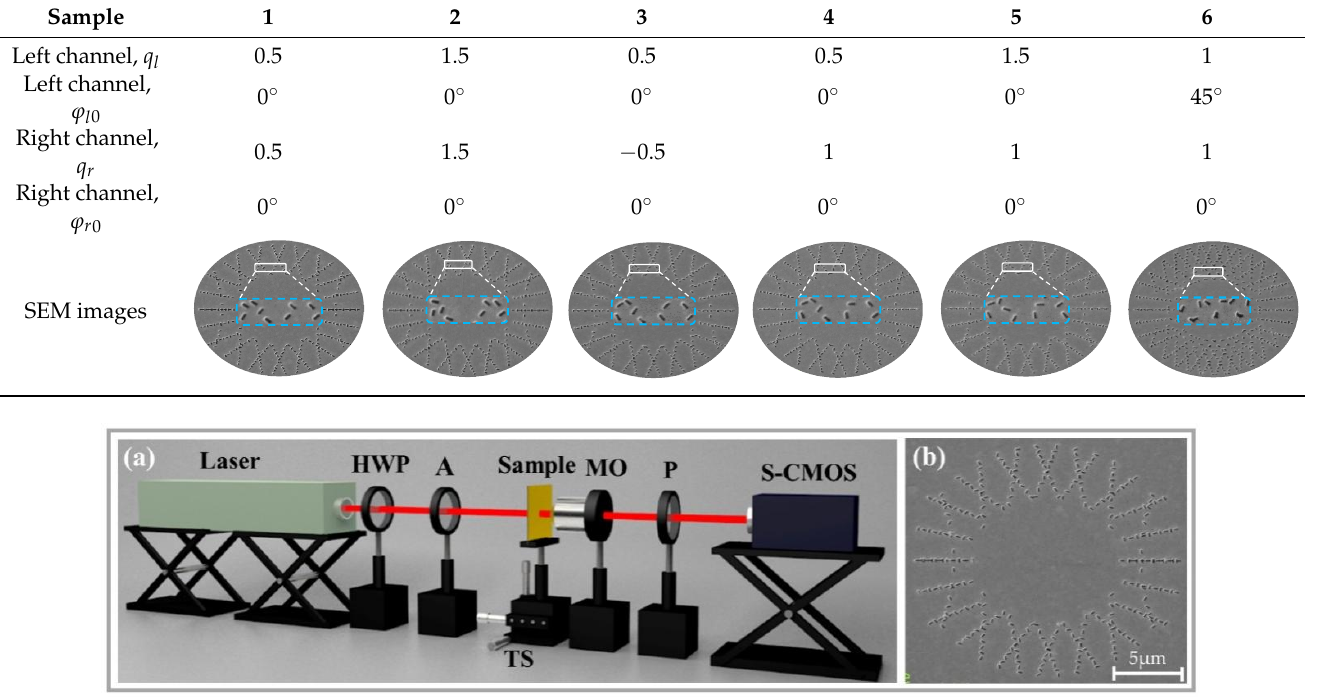
Figure 6. ( a ) Schematic diagram of the experimental setup. ( b ) SEM image of Sample 5. The results of the experimental demonstration for generating the dual channel FVBs are shown in Figure 7. By using the horizontally and vertically polarized light to illuminate Sample 1, respectively, the radially and azimuthally polarized dual-channel FVBs of order l l = l r = 1 are generated, and the obtained intensity patterns are shown in Figure 7a. The petals of intensity patterns of generated FVBs in the two channels rotate in the same direction with the rotation of the polarizer P. The distribution direction of the petals of the radially polarized FVBs is parallel to direction of the polarizer, while for the azimuthally polarized FVB, the distribution direction of the petals is perpendicular to that of the po- larizer P. Figure 7b gives the radially and azimuthally polarized dual-channel FVBs of orders l l = l r = 3 generated by Sample 2, respectively, under illuminations of